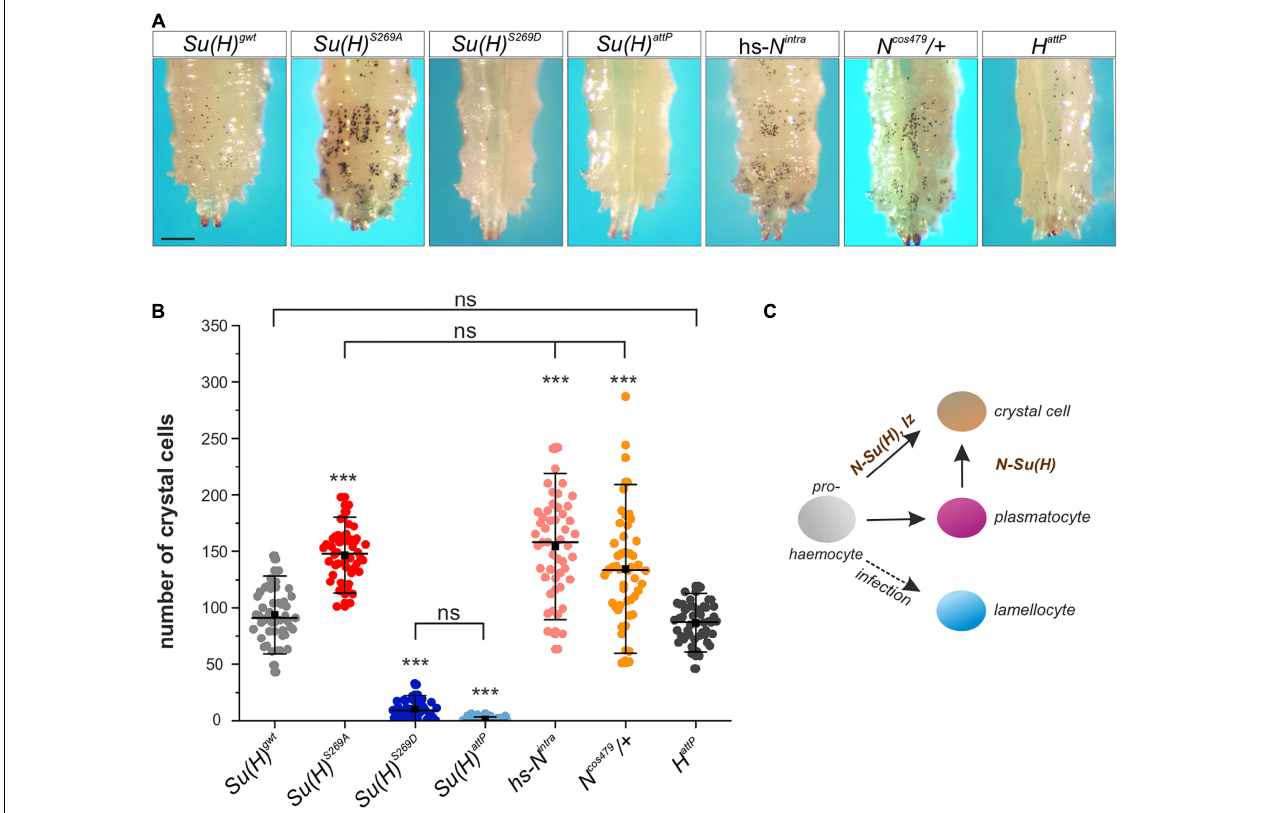
FIGURE 3 | Larval crystal cell number is altered in Su(H) phospho-mutants. (A) Melanized larval crystal cells, visualized through the cuticle of the indicated genotypes. Note that all are homozygous but N cos 479 . Heat-blackened sessile cells from the last two segments are shown. Scale bar represents 250 µ m for all panels. (B) Quantification of crystal cells from the last two segments in the indicated genotypes ( n = 50 larvae for all genotypes). Su(H) S 269 A , hs- N intra and N cos 479 / + had a significantly increased number of crystal cells, whereas H attP larvae displayed a level similar to the control. Crystal cells were barely detectable in Su(H) S 269 D and Su(H) attP homozygous mutant larvae. Every dot represents a measured larva. A black square represents the mean; horizontal bar represents the median, and error bars represent ± s.d. Statistical analysis by ANOVA two-tailed Tukey-Kramer approach: all samples but H attP deviated with high significance from the control Su(H) gwt (*** p < 0.001); in addition, not significant deviations are indicated (ns; p > 0.05). (C) Simplified scheme of hemocyte differentiation: the prohemocyte (gray) becomes either a crystal cell (beige), a plasmatocyte (purple) or, upon parasite infection, a lamellocyte (blue). Notch signaling controls crystal cell differentiation in the prohemocyte, and in the trans -differentiating